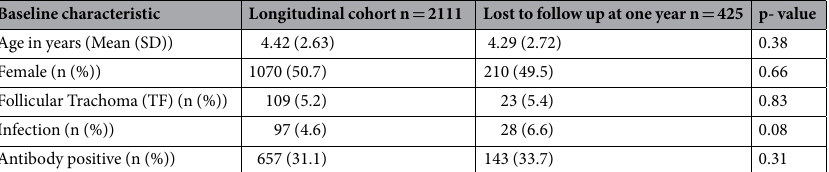
Table 1. Baseline characteristics of children age 1–9 years who were followed at one year compared to those not followed at one